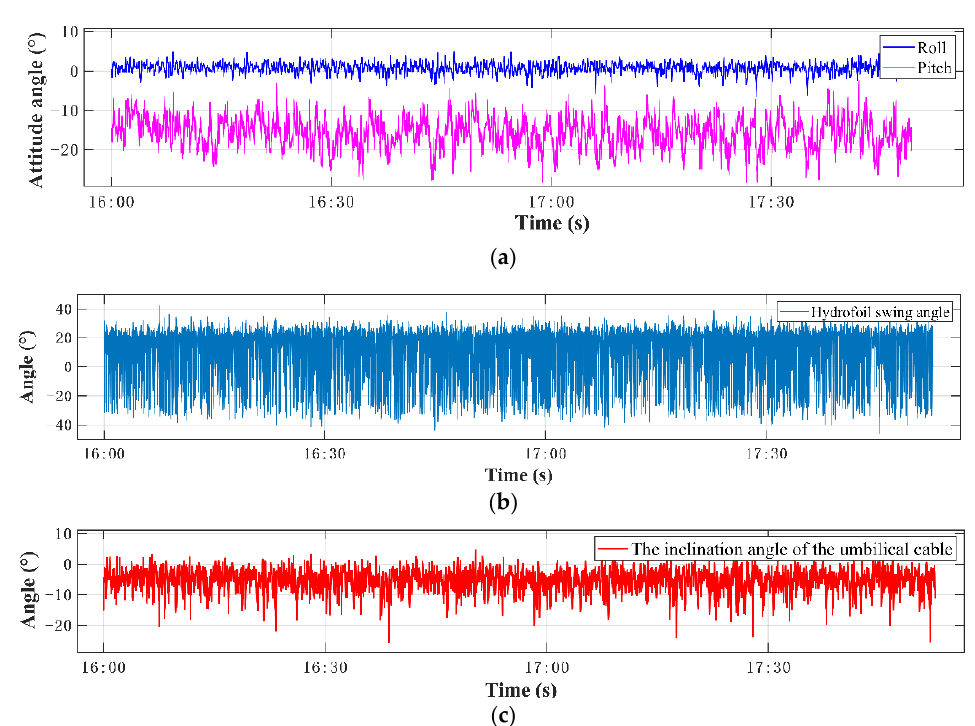
Figure 31. The attitude angle of the “ Black Pearl ” wave glider in the sea trial. ( a ) The pitch and the roll angles; ( b ) the swing angle of the hydrofoil; and ( c ) the inclination angle of the umbilical cable.